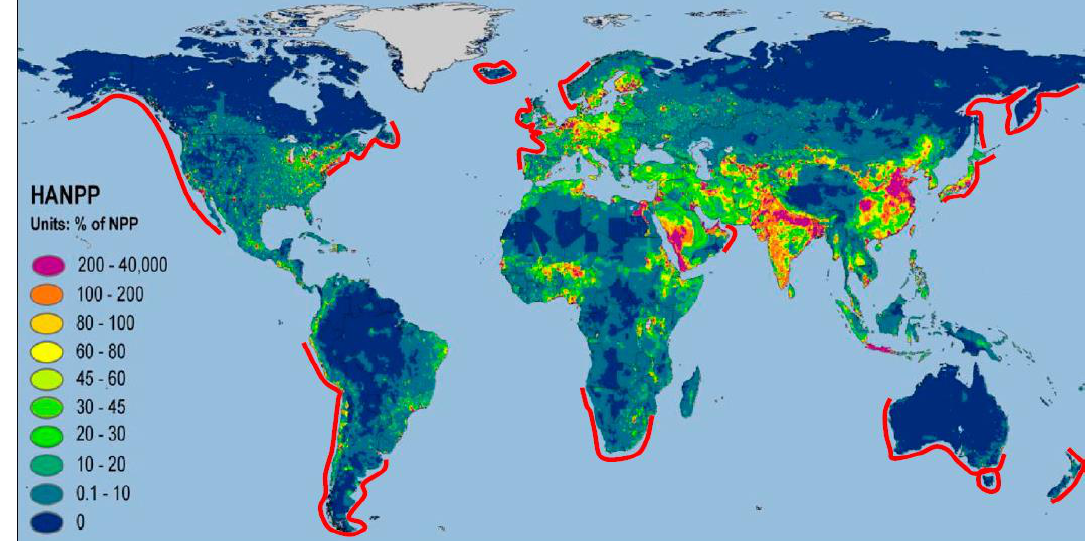
Figure 6. Natural distribution of macroalgae in shallow waters and the capacity of coastal areas for biogas and the percentage of local Net Primary Productivity (NPP). HANPP is Human Appropriation of Net Primary Production (Reproduced with permission from [64]. BioMed Central Ltd, 2012).